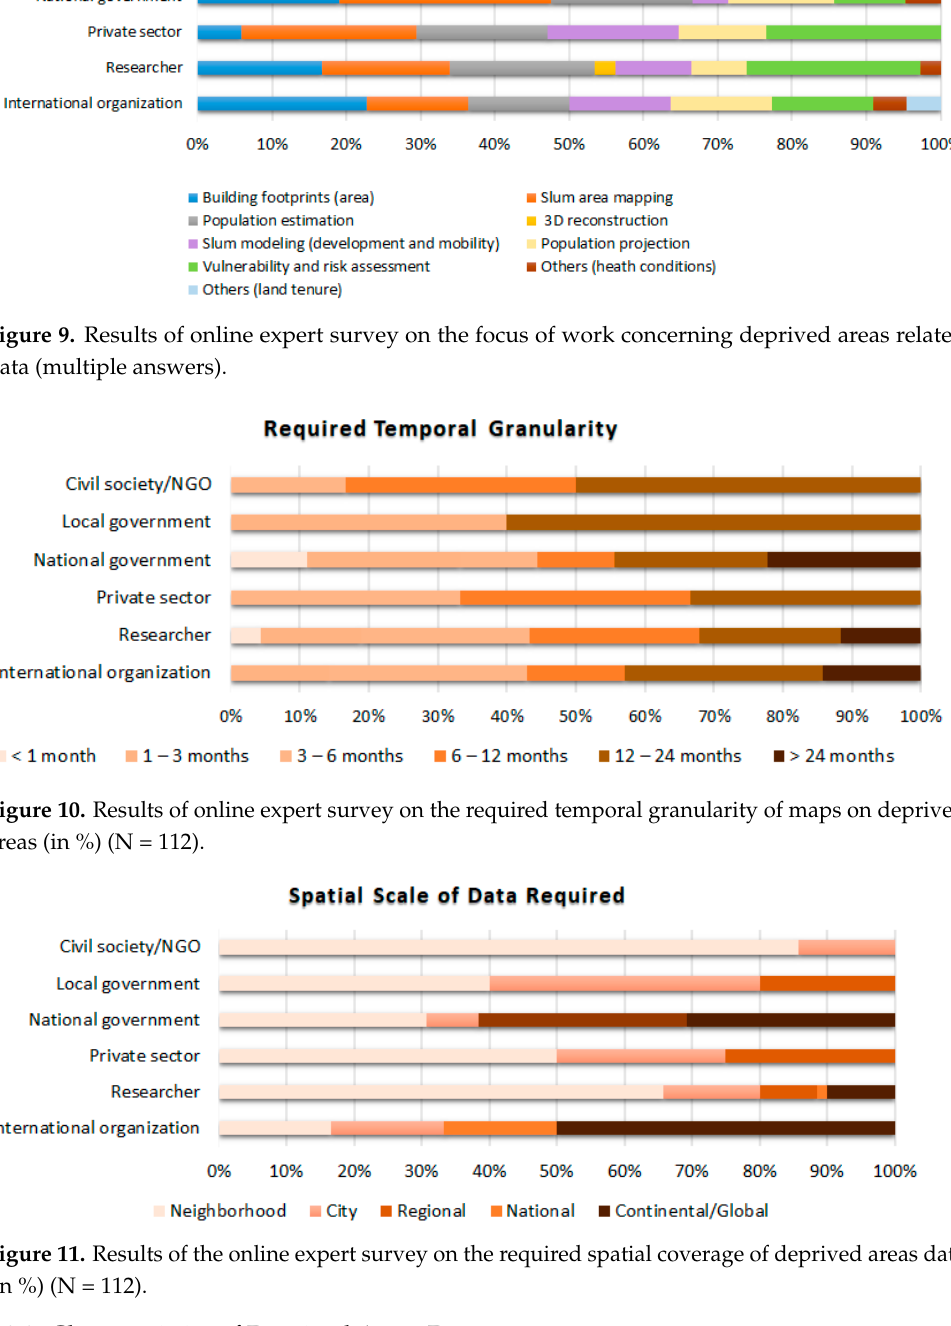
Figure 11. Results of the online expert survey on the required spatial coverage of deprived areas data (in %) (N = 112).